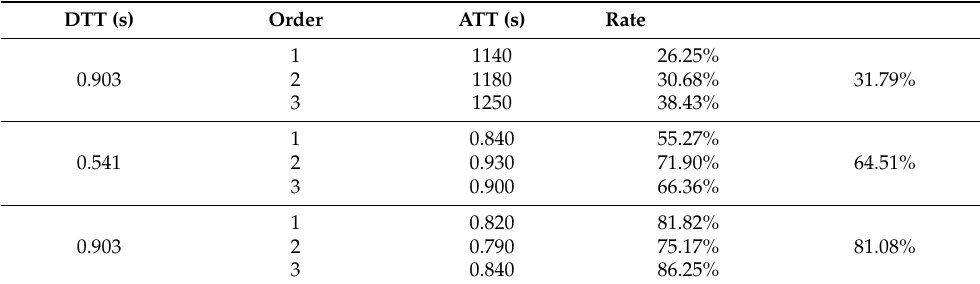
Table 4. Table of DTT and ATT in the